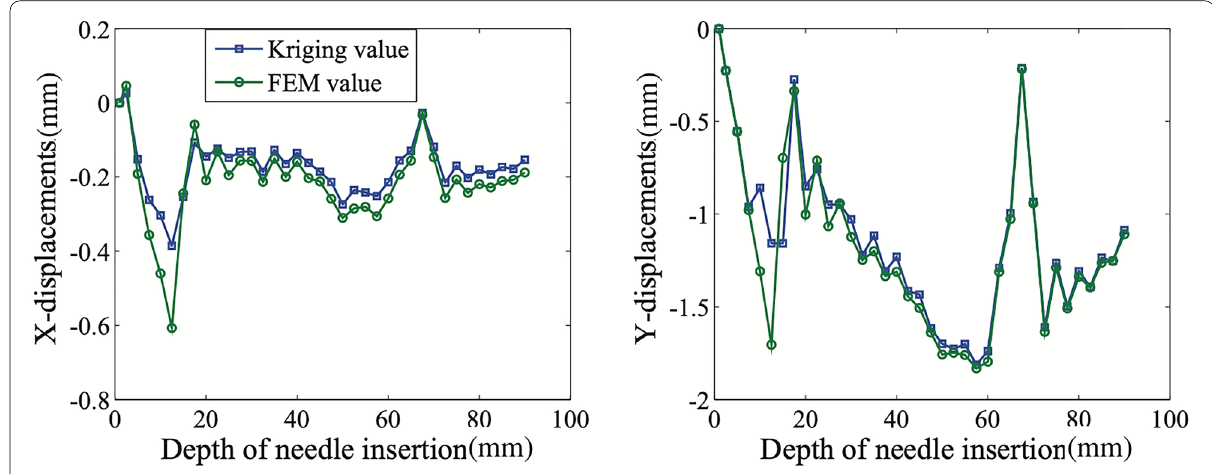
Figure 8 Kriging predictions for insertion depth-tissue displacement curve